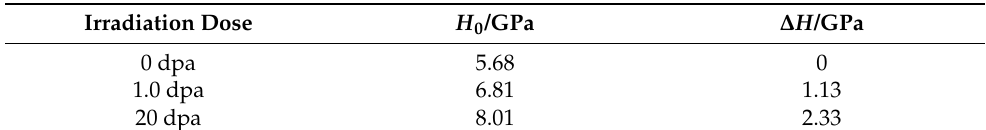
Table 2. Calculated H 0 and ∆ H based on the Nix–Gao model of specimens at different irradiation doses.